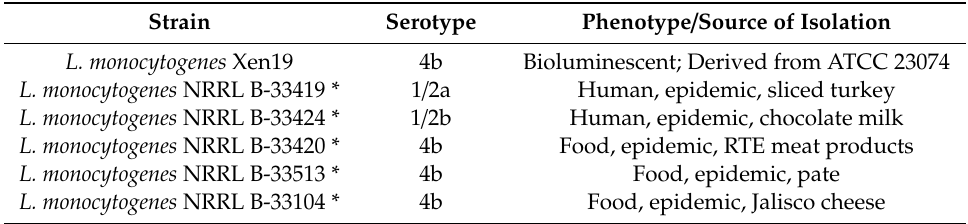
Table 1. Listeria monocytogenes strains used in this